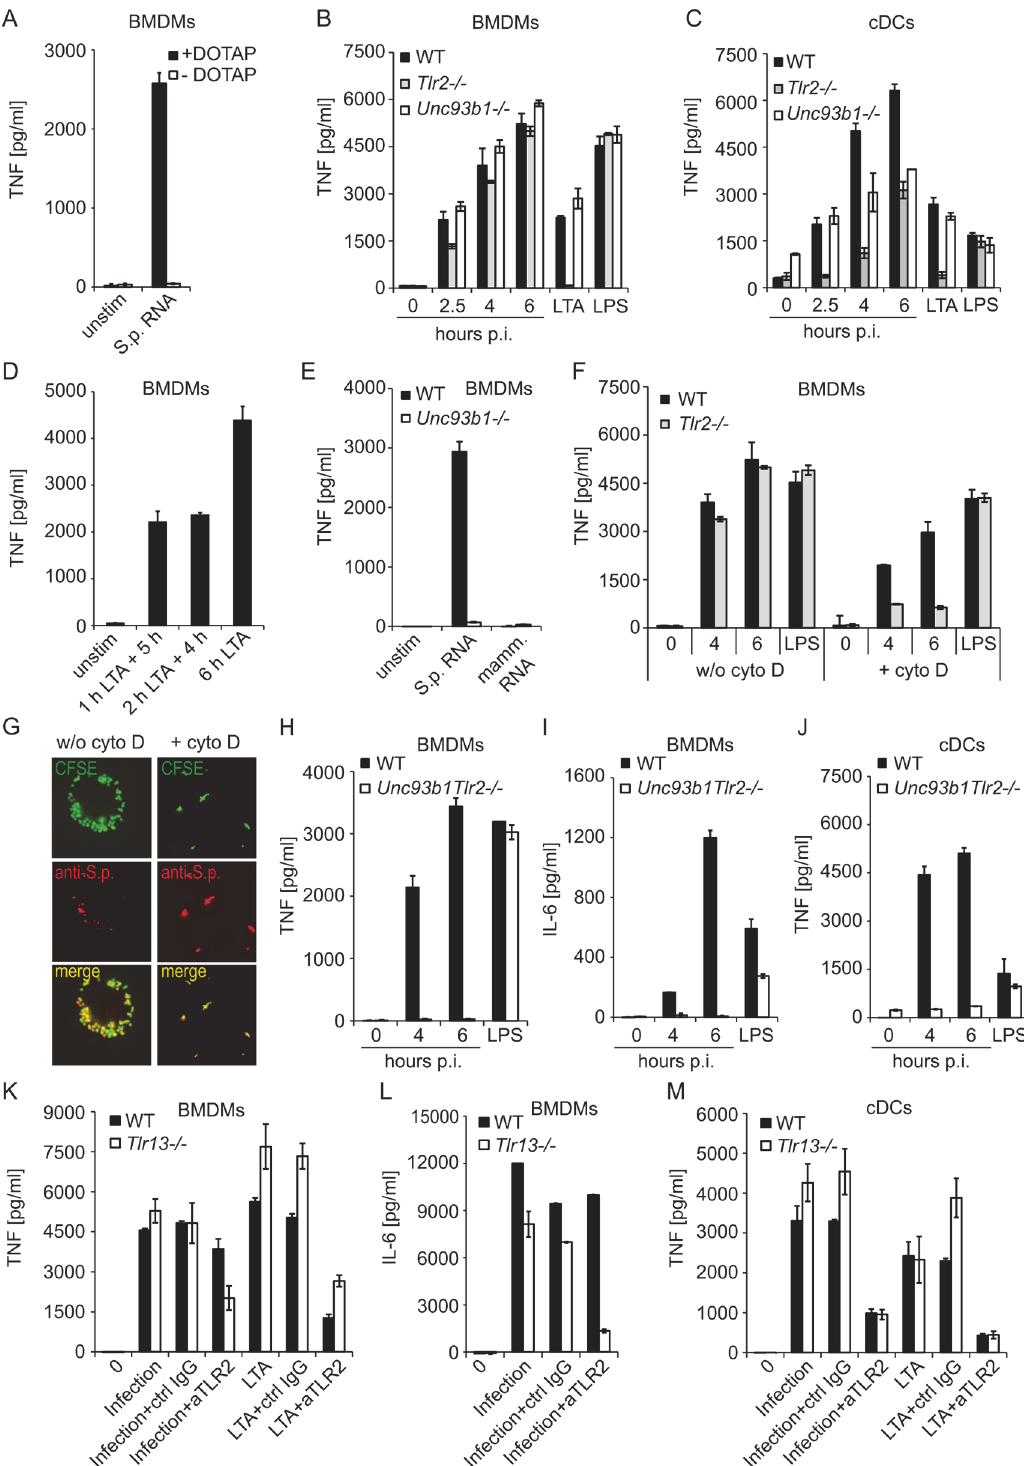
Fig 2. S . pyogenes is recognized by a combination of Tlr2- and Tlr13-mediated sensing. (A) S . pyogenes RNA was either added directly to the BMDMs or transfected into BMDMs using DOTAP. Supernatants were collected after 6 h and TNF release was measured by ELISA. (B, C) BMDMs (B) or cDCs (C) from Tlr2 − / − and Unc93b1 − / − mice as well as control mice (WT) were infected with S . pyogenes (MOI = 50) or left uninfected, or treated with LTA or LPS as a control. At indicated time points, supernatants were collected and TNF release was measured by ELISA. (D) BMDMs were stimulated for 1 or 2 h with LTA,